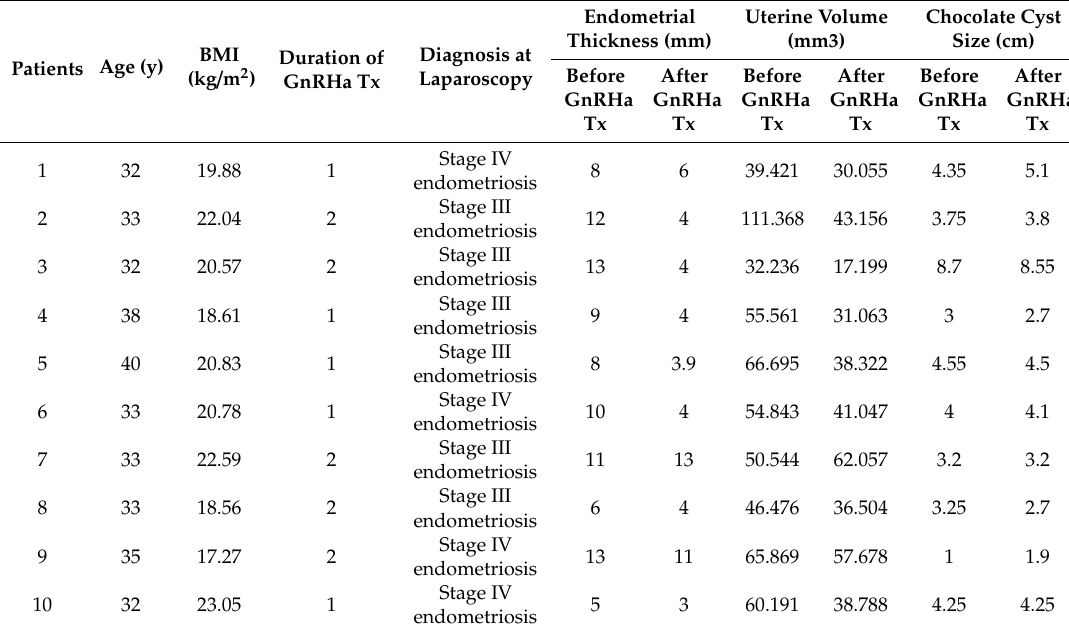
Table 2. Characteristics of women with endometriosis involved in the follow-up